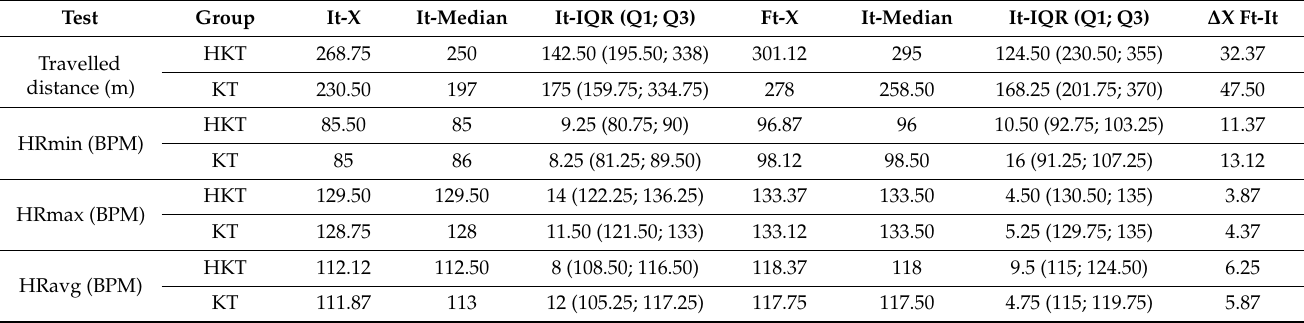
Table 5. Statistical analysis of 6-min walk test